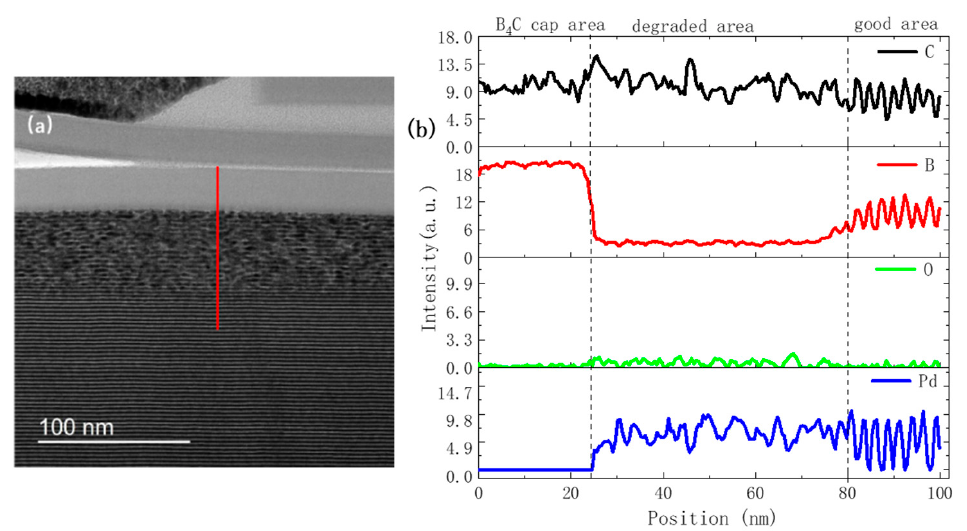
Figure 6. TEM image ( a ) and electron energy loss spectroscopy (EELS) line scan ( b ) of the surface area of the 50% humidity multilayer after 13 months of storage.